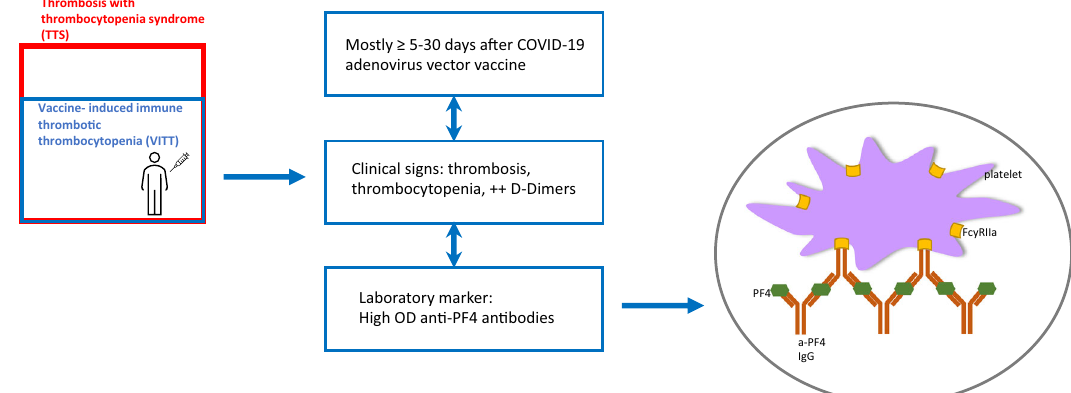
Fig. 1 VITT: an overview of the disease. VITT is a newly identi fi ed disease, which occurs very rarely post adenovirus vector COVID-19 vaccines. Crucial clinical and laboratory signs of the disease are: thrombosis with thrombocytopenia, elevated D-dimers, high levels of anti-PF4 antibodies as measured by ELISA. Secreted anti-PF4 immunoglobulins (IgG) can form aggregates with PF4 in the blood circulation. These aggregates can activate platelets and trigger the downstream prothrombotic cascade. Worldwide, the exact number of VITT among all TTS cases after adenovirus vector COVID-19 vaccination remains currently unresolved due to the limited availability of anti-PF4 antibody